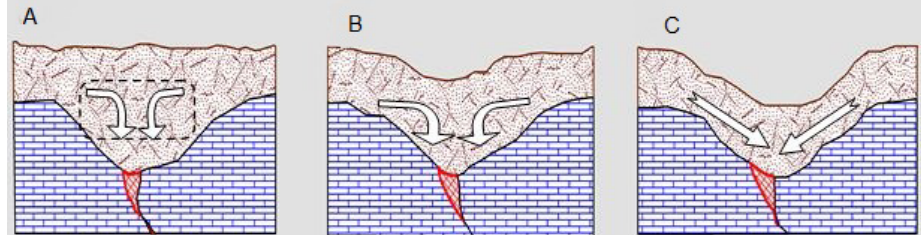
Figure 2. The mechanism of occurrence of cover-subsidence sinkholes. ( A ) existence of soil or non-continuous materials (units PlQc, PlQcm) or over the Oligo-Miocene limestones; ( B ) water flow washes soils over the karstic bedrock and transports it through big fractures into the underground parts; ( C ) continuous transportation of sediments through cracks and fractures, as well as the occurrence of the sinkhole.